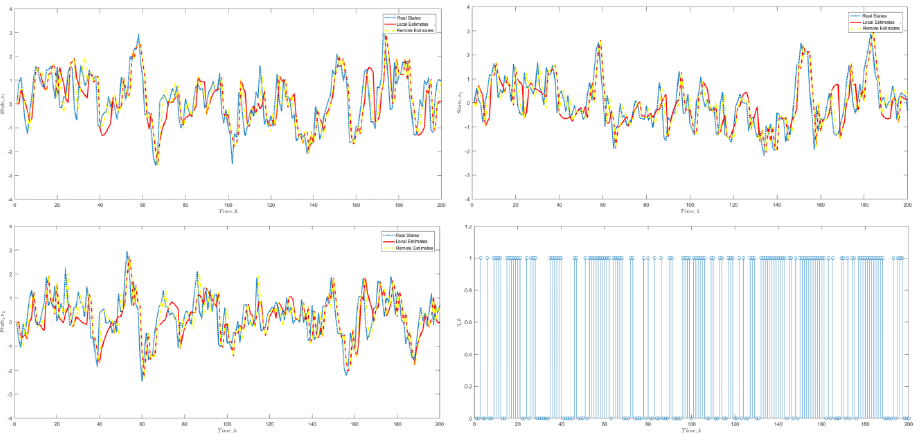
Figure 4. Estimation performance of state without the periodic transmission schedule.